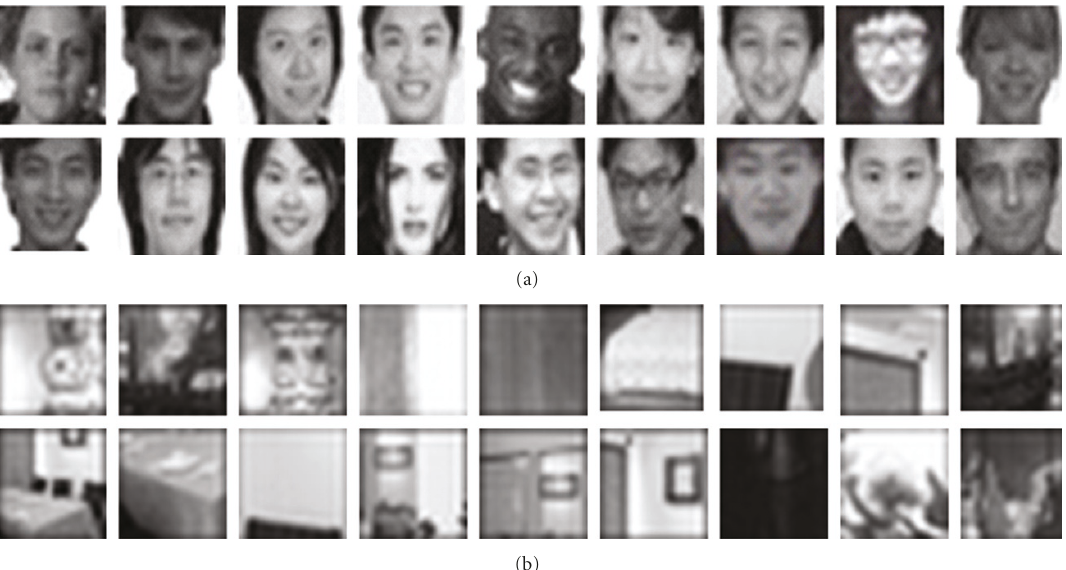
Figure 6: Database of face detection system. (a) Face images, (b) Non-face